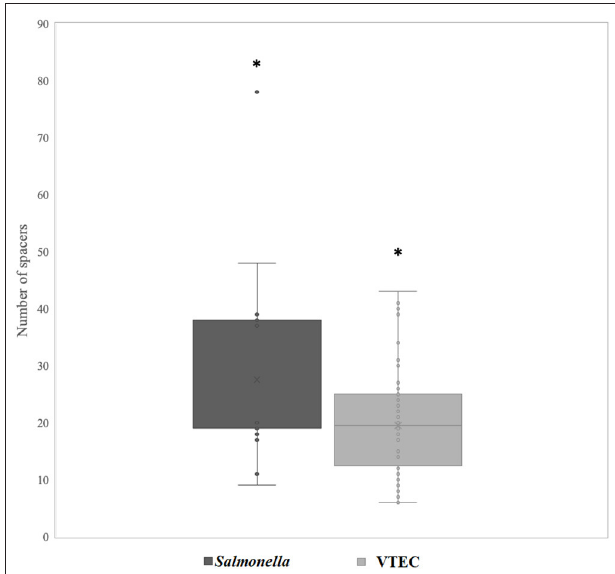
FIGURE 6 | Number of spacer regions in Salmonella and VTEC. Asterisks indicate significance below α = 0.05 (Student’s t -test).